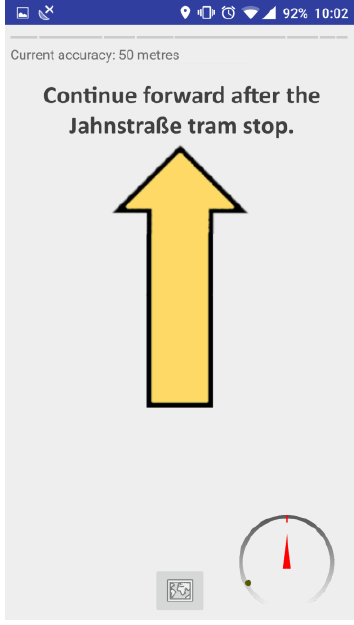
Figure 5. Navigation instruction within the mobile client app.